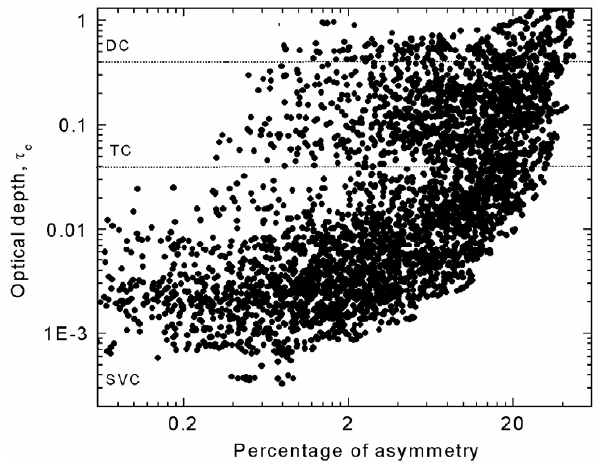
Fig. 6. A scatter plot showing the variation of percentage asymme- try of tropical cirrus with corresponding variations in cloud optical depth ( τ c ) from individual profiles on different